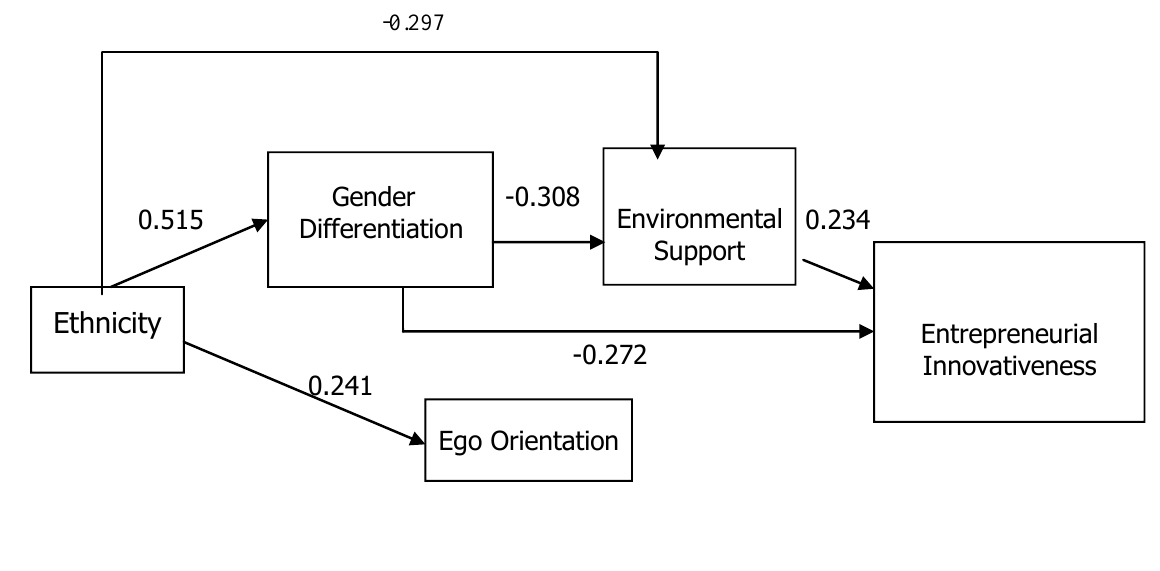
Figure 2: Multiple regressions on the trimmed model Table 3: Indirect effects of ethnicity and gender differentiation on entrepreneurial innovativeness Variables Ethnicity – Entrep. Innov.